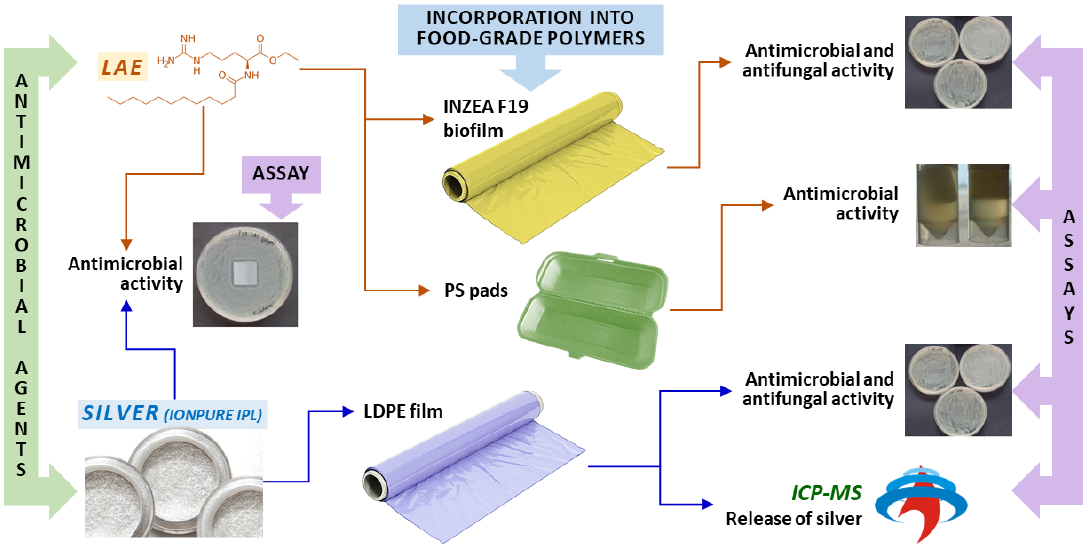
Figure 1. Flowchart of the different experiments carried out during the present study (colors of the polymers do not correspond to the actual ones).